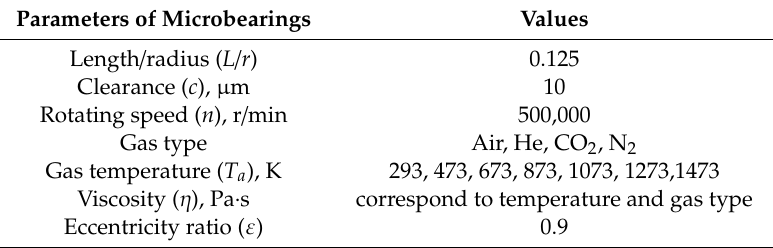
Table 1. Model parameters of the gas-lubricated